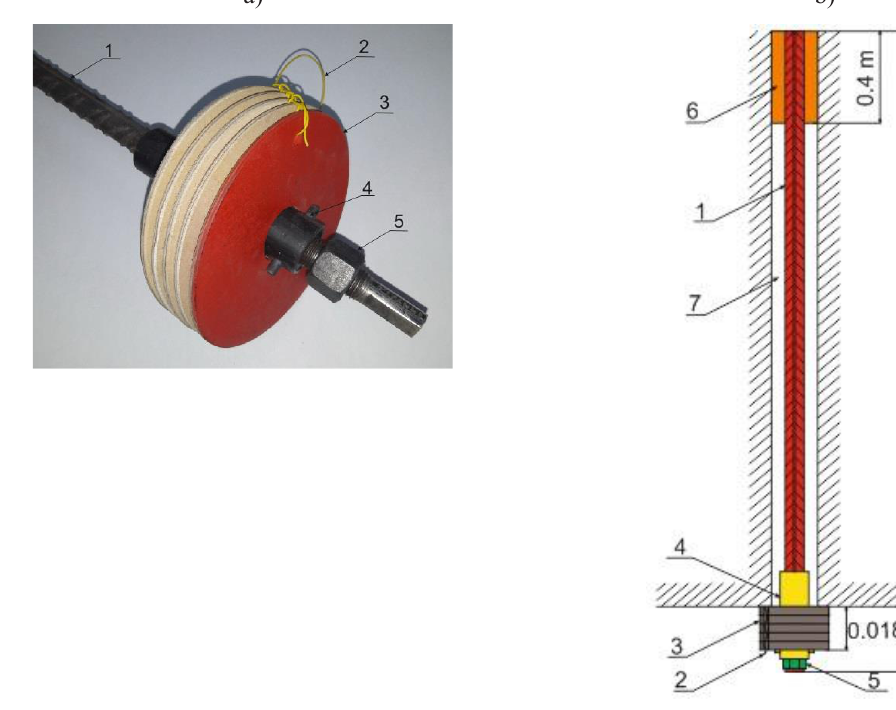
Figure 1: Roof-rock delamination detection system; a) Components; b) longitudinal cross-section; ribbed rod; 2 – cord; 3 – Bakelite plates